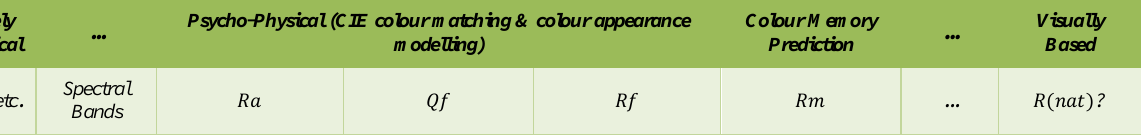
Figure 5. Illustrating the concept of the Fidelity